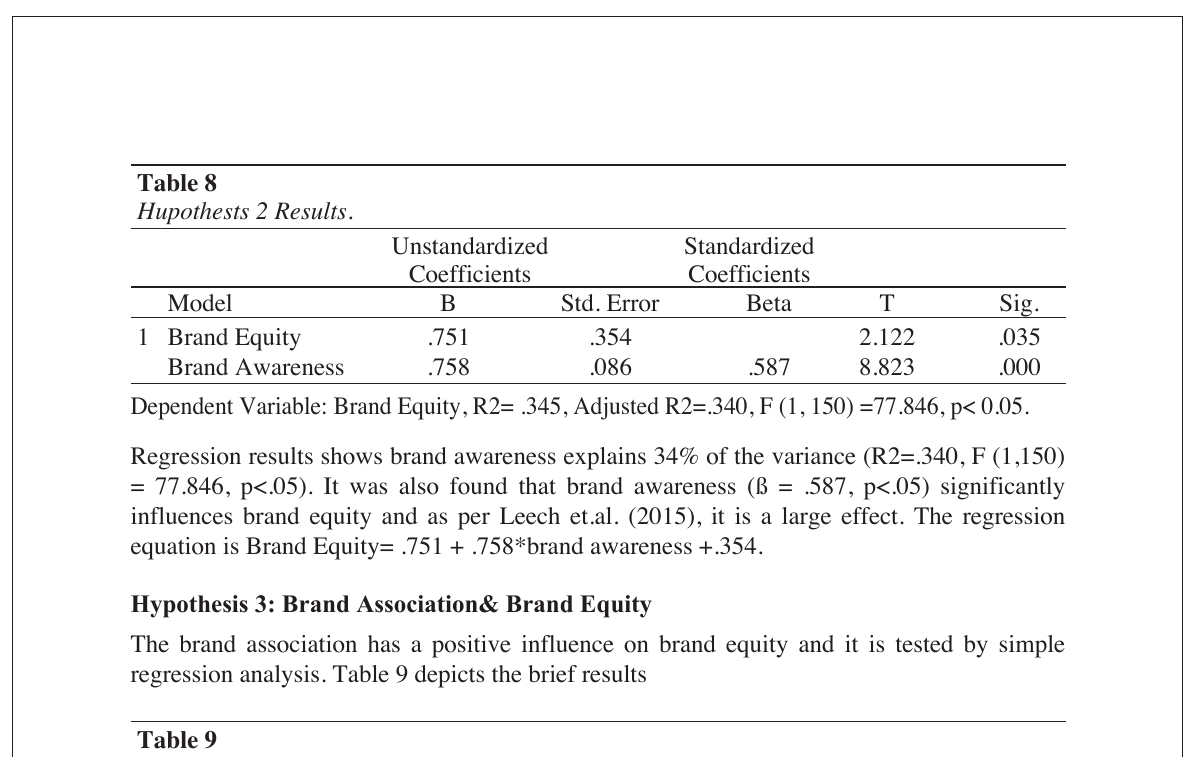
Hupothests 3 Results.